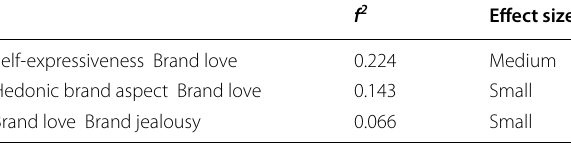
Table 6 Results of f 2